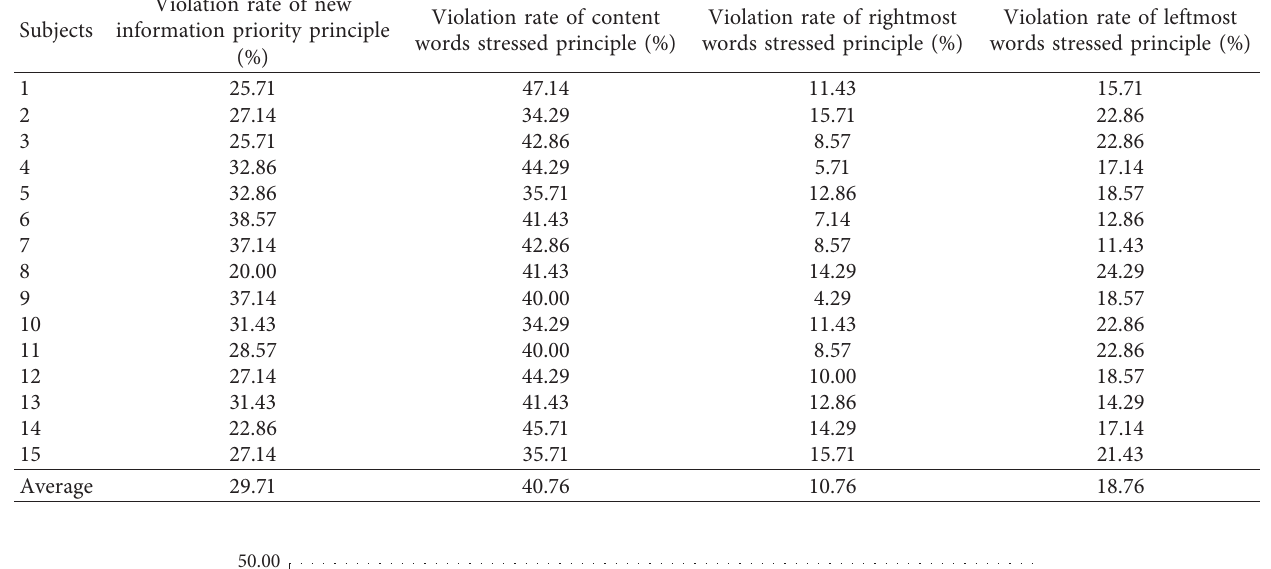
Table 2: The violation rate of four constraints of nonnative speakers.